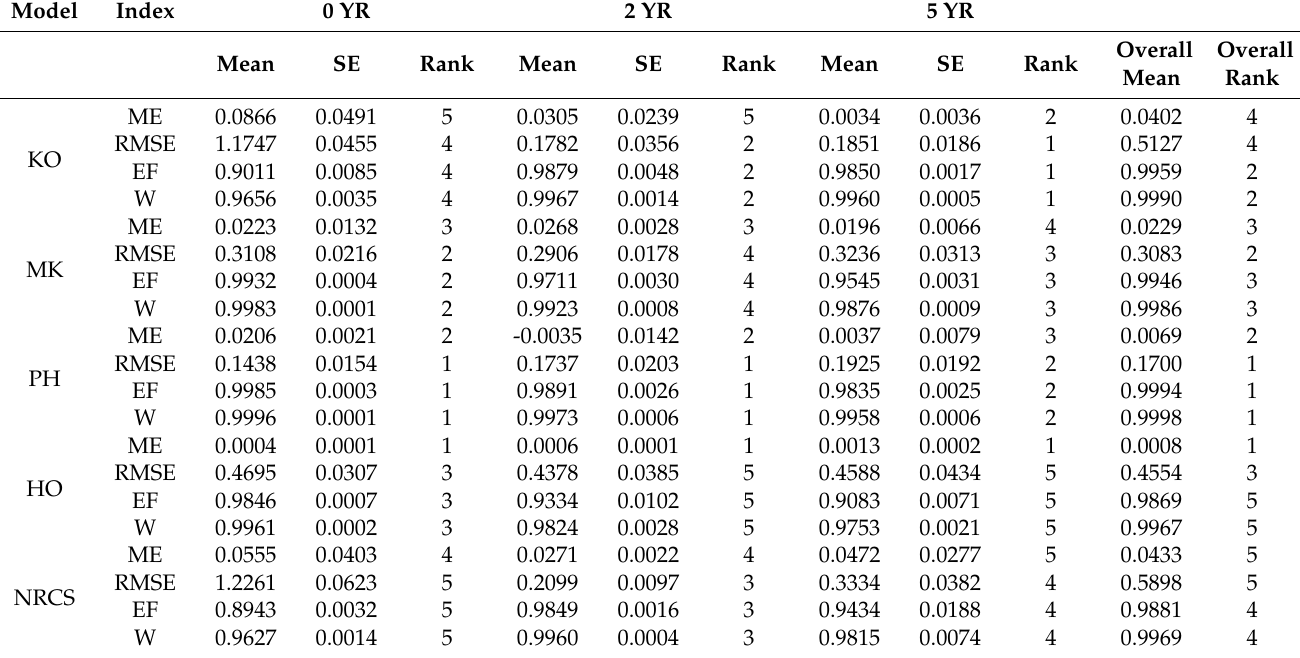
Table 4. Evaluation indices of the five evaluated soil infiltration models for TWW irrigated soils at